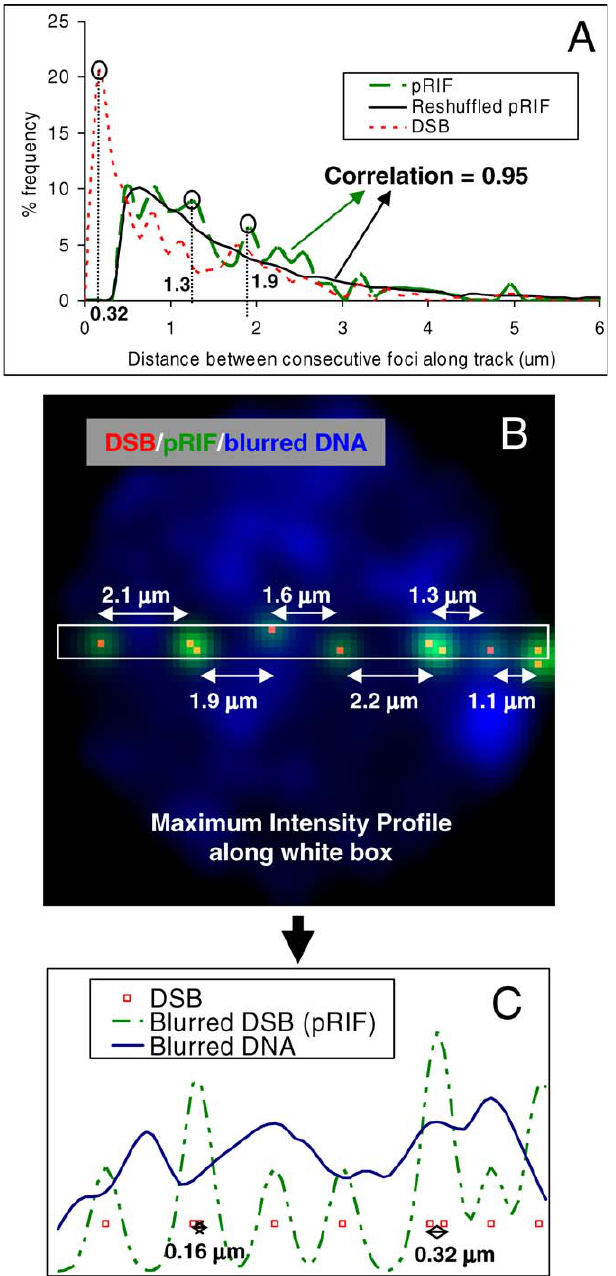
Figure 3. Comparison of Image Prediction and Monte Carlo Simulation for DNA Damage Distance Distribution (A) shows the distribution of distance between consecutive foci along the track for a set of 197 simulated nuclei exposed to a theoretical 1 GeV/ amu Fe track. (B) illustrates a simulated nucleus: DSB are shown in red, DNA densities and DSB blurred with the PSF in blue and green, respectively. pRIF, blurred DSB, are identified by detecting maxima along the intensity profile (C) sampled over a narrow strip of the image in (B). These profiles are obtained by computing the maximum intensity projection of a 0.8- l m thick line aligned with the particle track. Some of the distances reported for this illustrated track are also shown in (B) and (C) and labeled correspondingly in (A). The average DSB distance distribution over all 197 nuclei is shown by the red dotted curve showing an expected Poisson-like distribution. The corresponding distance distribution for pRIF is shown as the dashed green curve and is similar to the DSB distribution except for the frequency of close-by foci that have diminished (i.e., need at least more than two-pixel gap to be separate, which corresponds to 0.48 l m). We could reproduce